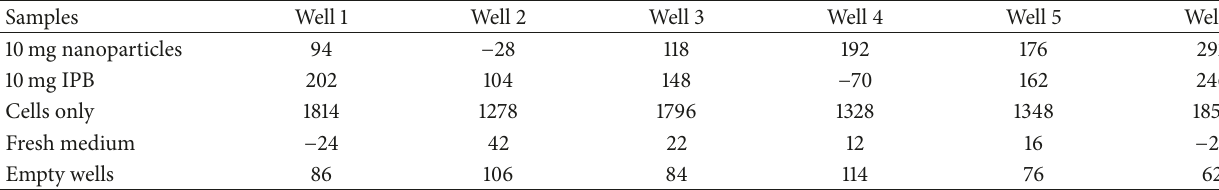
Table 4: Signal from viable cells (step 2 − step 1).